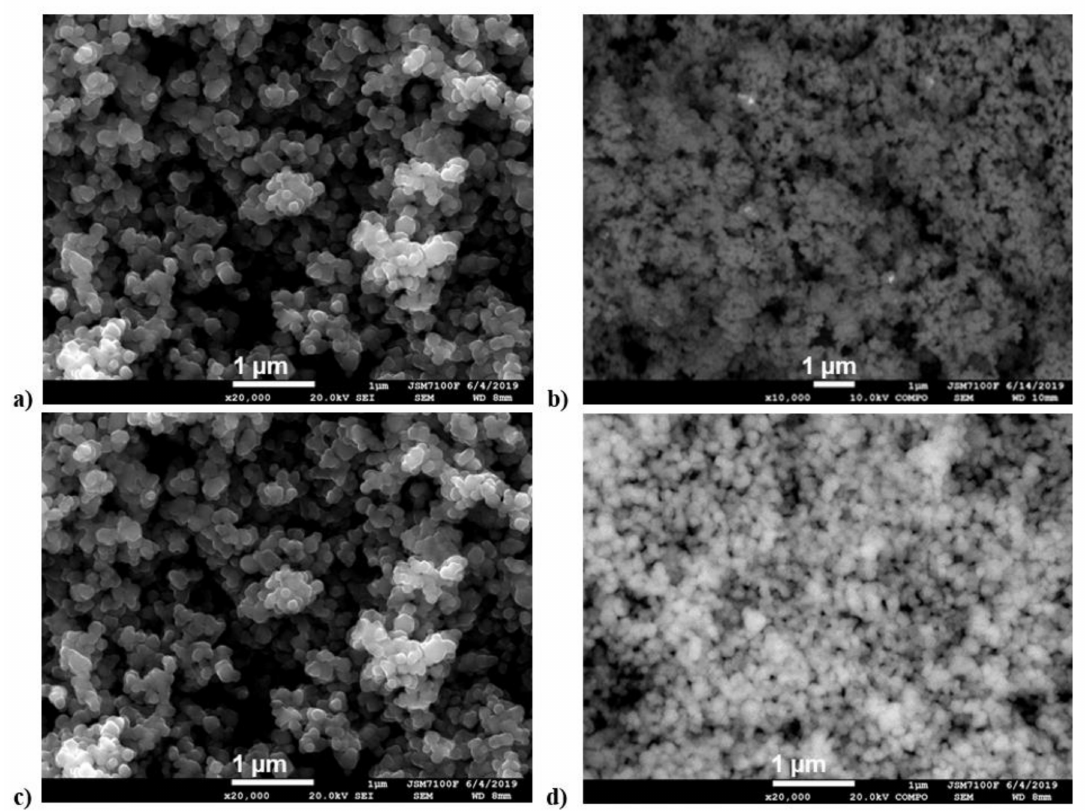
Figure 3. SEM micrographs: ( a , b ) of TiO 2 -Pd/IWI) and ( c , d ) TiO 2 -Au/IWI.